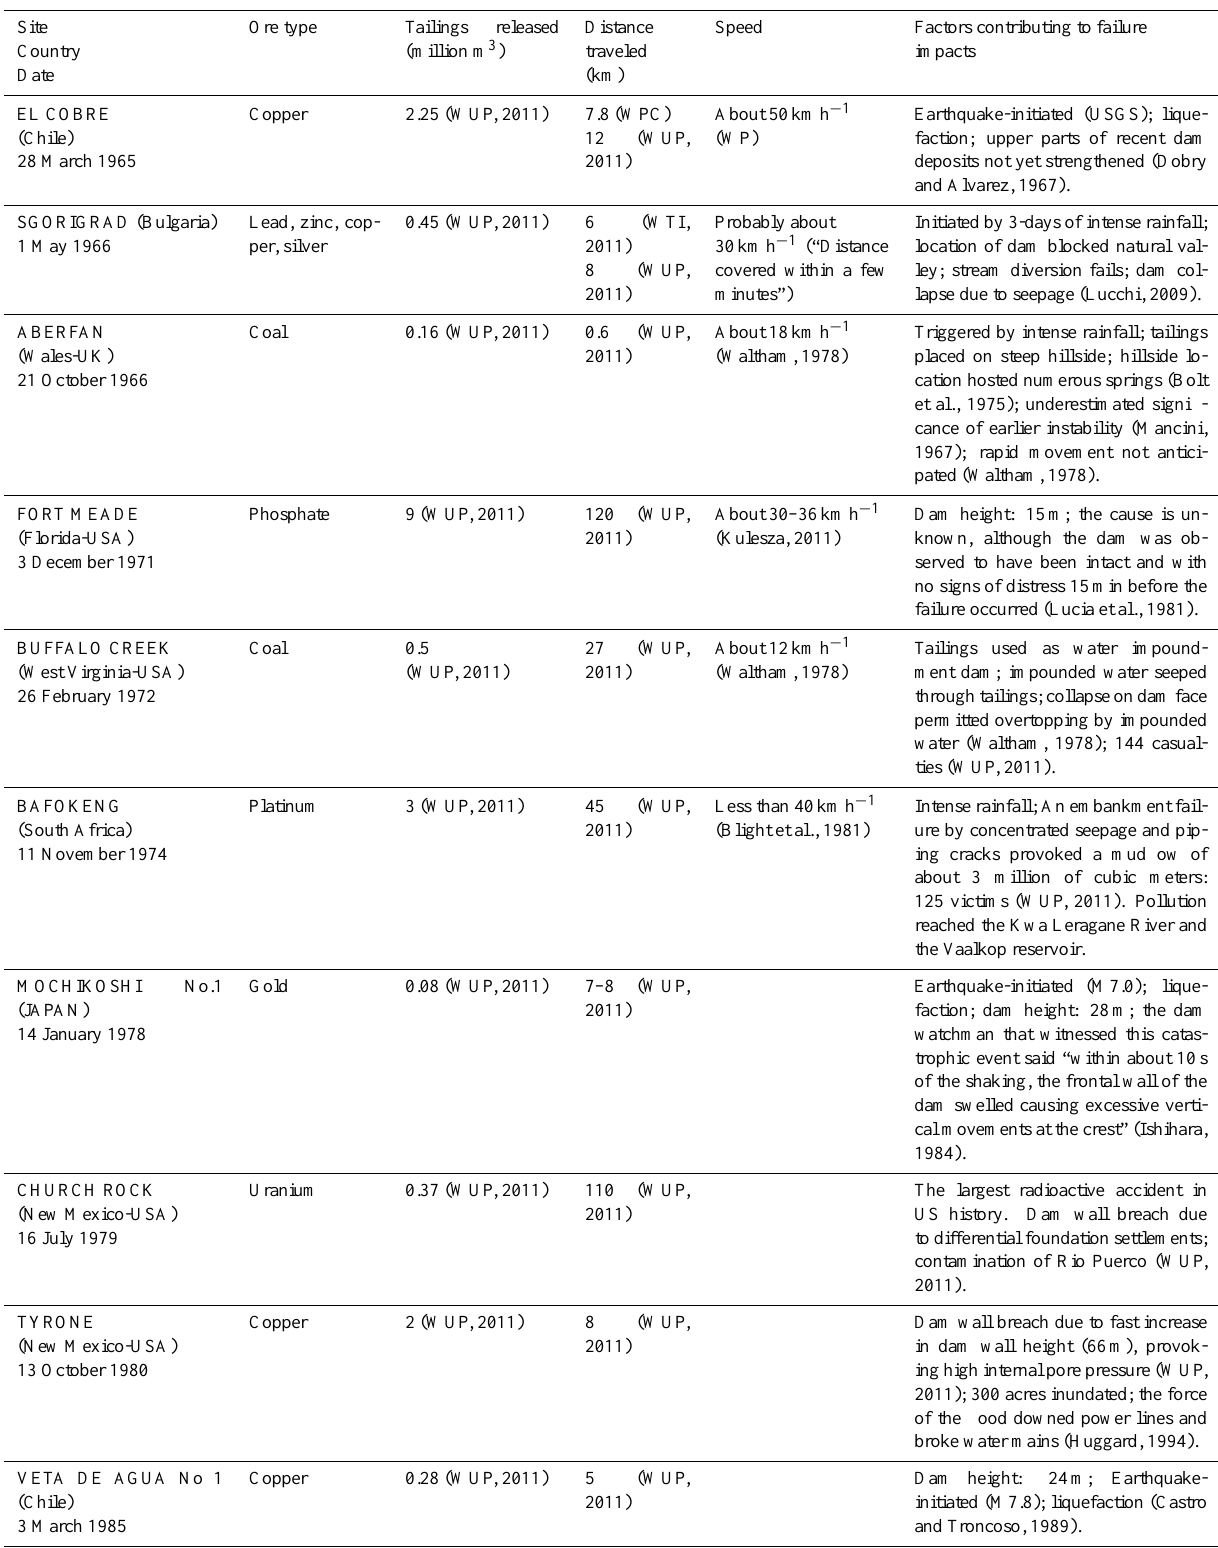
Table 3. Distance traveled and speed of the mudflow that occurred due to the failure of tailings dams in the period 1965–1985. Site